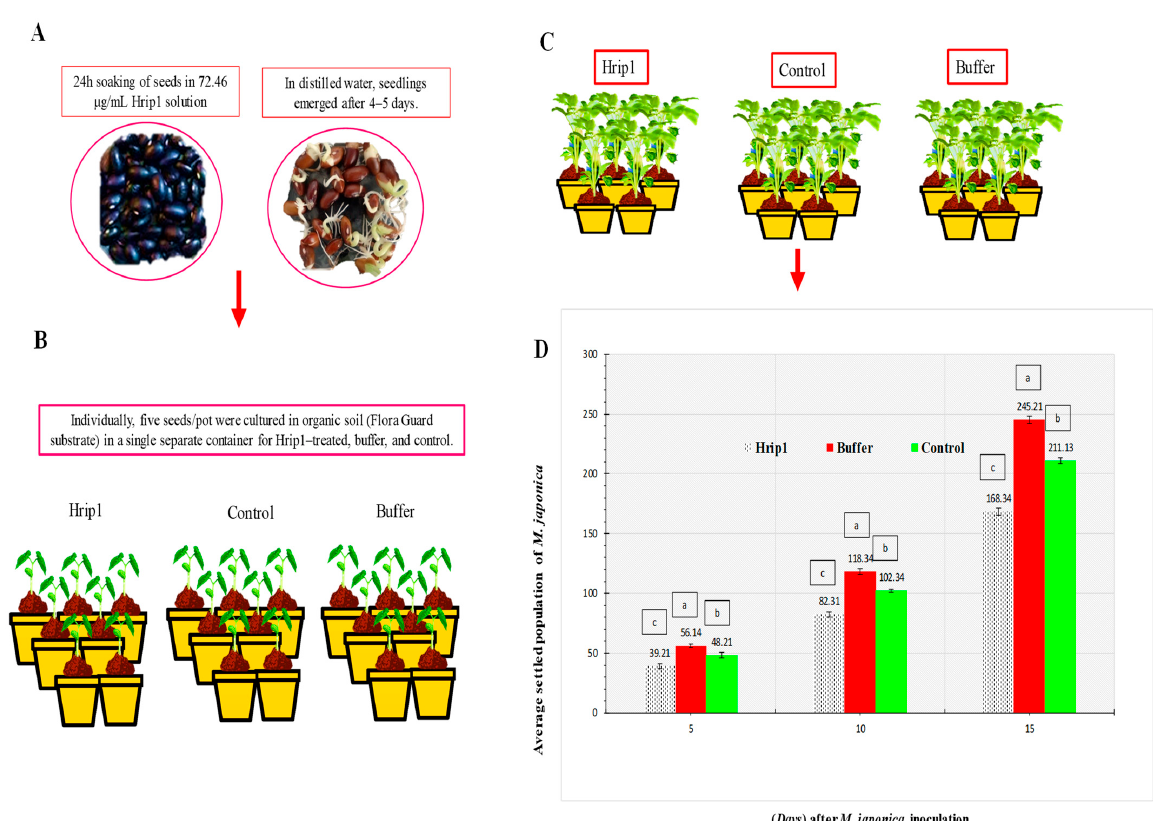
Figure 1. Megoura japonica population differences were observed in Hrip1-, control-, and buffer- treated P. vulgaris seedlings. Using one-way ANOVA and Levene’s test with SPSS 18.0, the LSD was at p = 0.05. ( A , B ) Treatment of seeds and seedling of M. japonica . ( C ) After 7 d, seedlings were inoculated with 15–20 adults of M. japonica ; ( D ) seedlings treated with Hrip1 saw a substantial aphid population loss (mean ± SD); (a–c) the significant differences among Hrip1, buffer, and control. The study used a CRD, randomized statistical design; LSD and one-way ANOVA were used to compare data ( p = 0.05).